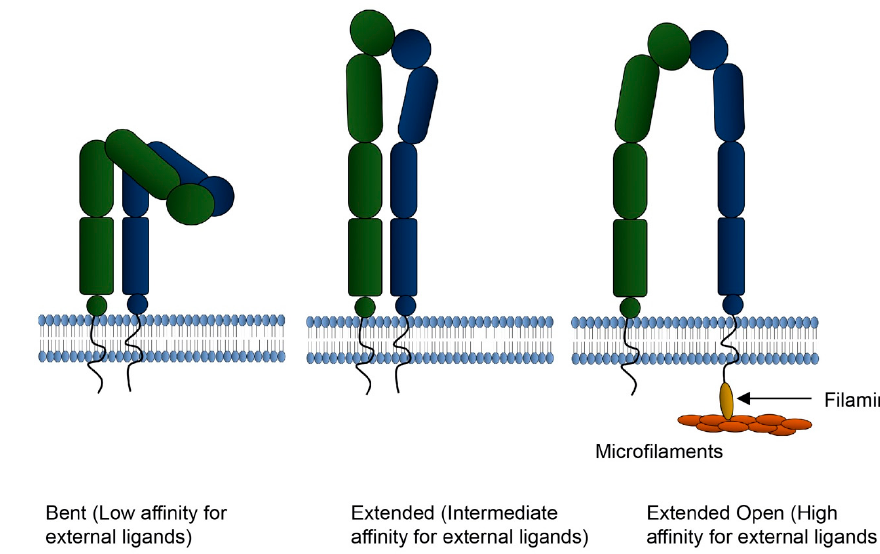
Figure 6. Integrins can take on multiple conformations. In the bent conformation the integrin does not bind external ligands. In extended conformation, integrins bind ligands with intermediate affinity. In the extended open conformation integrins bind ligands with high affinity. Attachment of talin to the cytosolic (luminal) domain of the beta3 integrin can promote the high affinity bonding conformation. In the schematic, alpha integrins are on the left, beta integrins are on right. As described in text, filamin and other integrin–associated proteins can regulate the conformation of integrins by associating with the cytosolic domain.